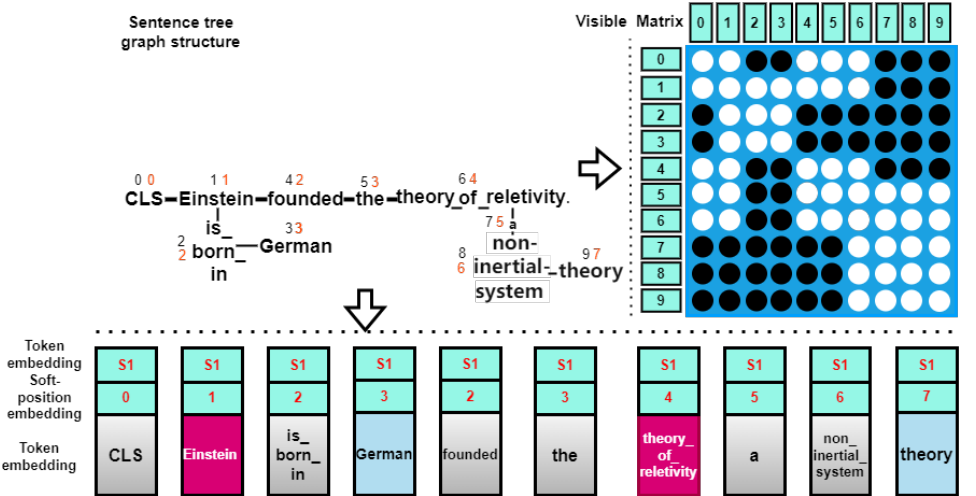
Figure 7. The principle of mapping sentence trees to transition matrices and the process of converting to embedding representations. In the graph structure of the sentence, the black numbers are hard position indices, and the red numbers are soft position indices. (1) For token embedding, the sentence tree is serialized into token embedding according to the hard-position index; (2) for the soft-position embedding, use it as position embedding along with the token embedding; (3) in segment embedding, the all the first tokens in a sentence are recorded as an “A”; (4) in the visible matrix, white means visible and black means invisible. For example, the cell in column 3, row 9, is